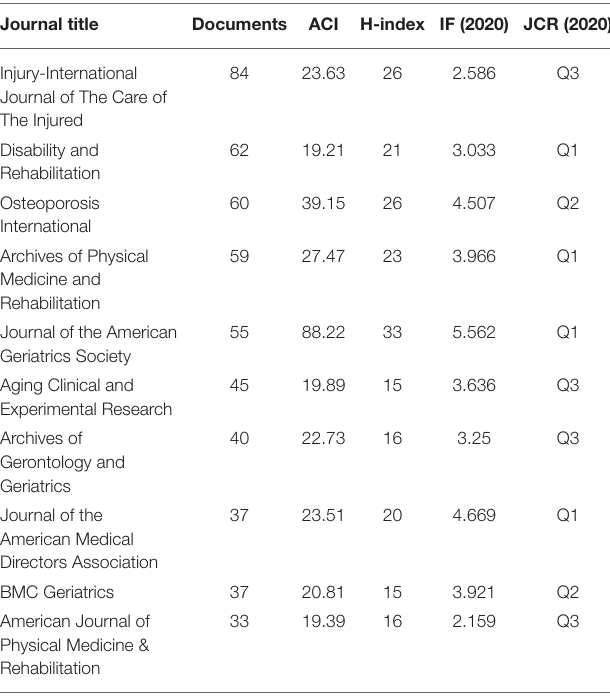
TABLE 1 | Top 10 journals in the study on rehabilitation of hip fracture in the elderly ranked by the publication